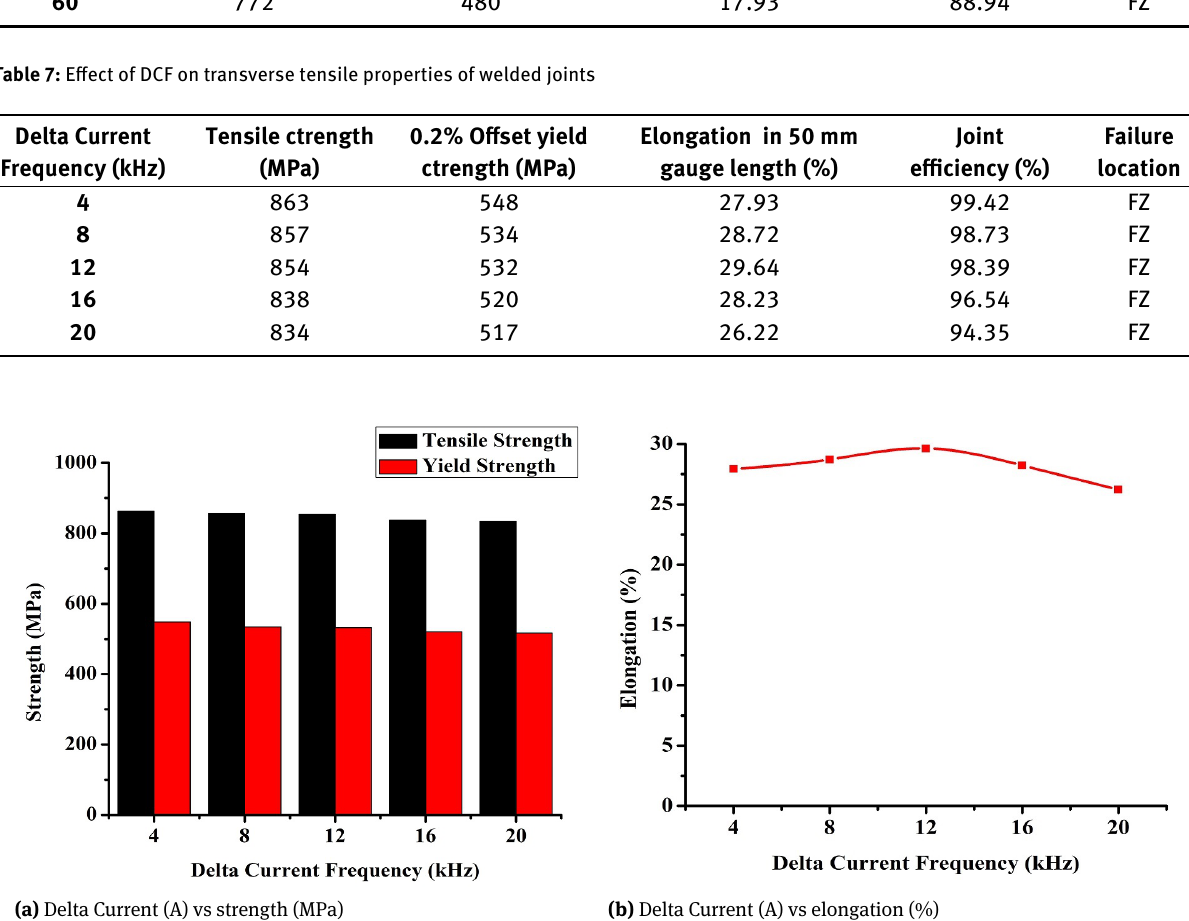
Figure 7: Effect of DCF on tensile properties of welded